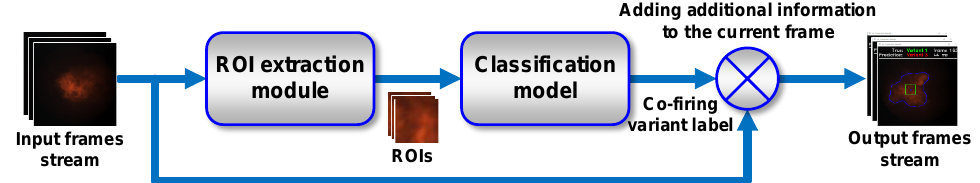
Figure 11. The general principle of operation of the application for testing the method of identifying variants of the co-firing process.